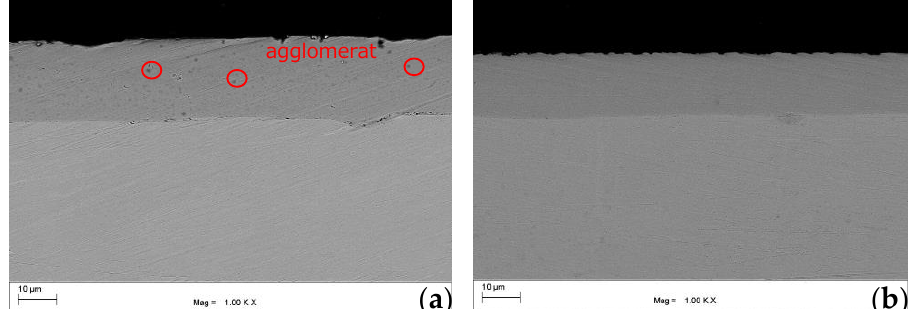
Figure 5. FESEM pictures of the cross-sections of ( a ) sample-II and the ( b ) sample-IV.